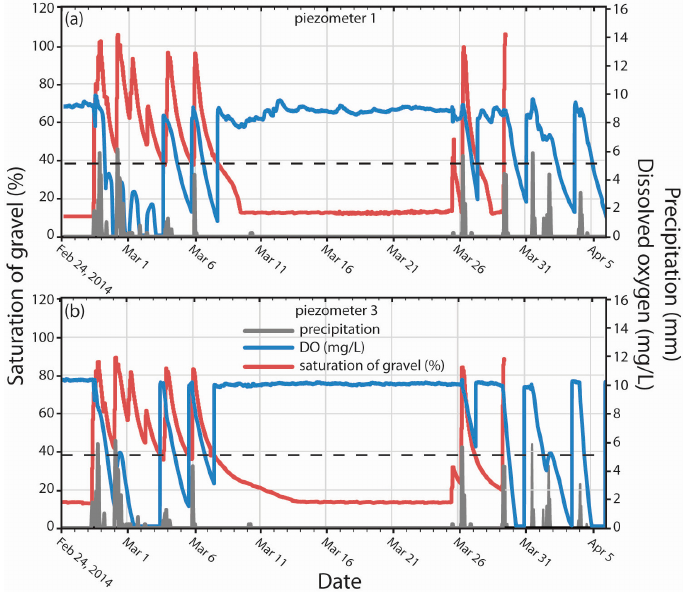
Figure 5. Hourly time series of saturation of gravel (%) (red line), dissolved oxygen (DO) concentration (mg ∙ L ‒ 1 ) (blue line), and precipitation (mm) (gray line) for: ( a ) piezometer 1; and ( b ) piezometer 3 for 24 February to 5 April 2014. The dashed line at 39% saturation of gravel is the depth of the DO sensor. Saturation of gravel data are missing for 29 March to 5 April 2014.